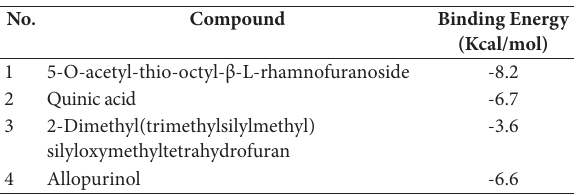
Table 4. The binding energy of ligands in a complex with a re- ceptor (XO) is obtained by molecular docking.